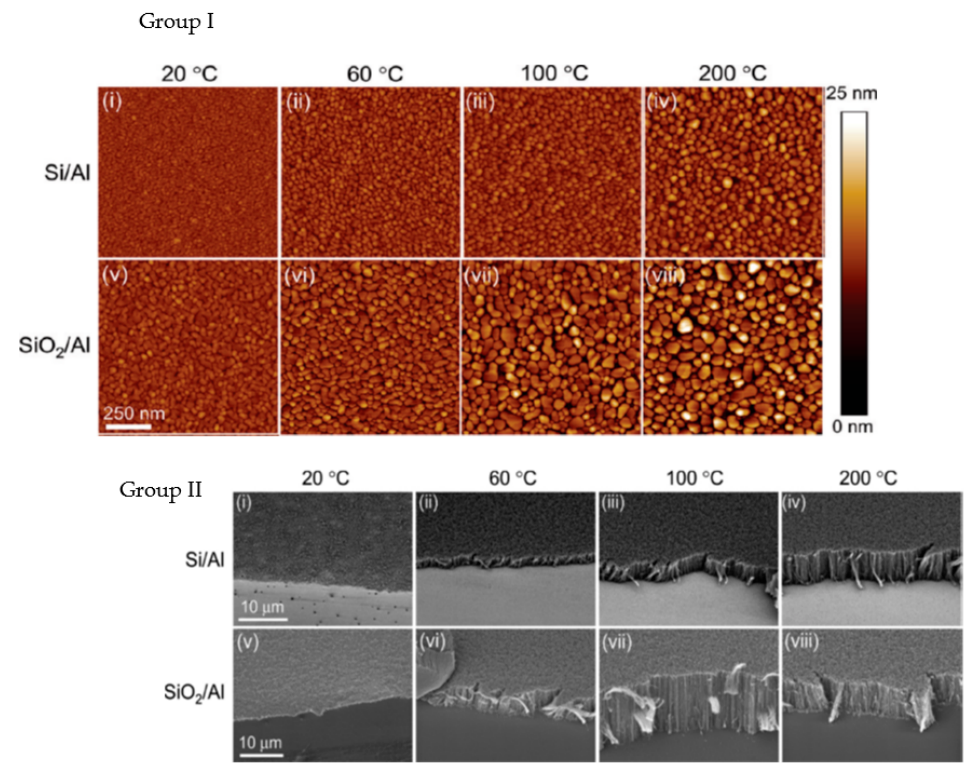
Figure 2. Group I ( i – viii )—AFM tapping mode height micrographs of Si, i.e., native SiO 2 , ( i – iv ) and SiO 2 ( v – viii ) with 10 nm Al DBL deposited at substrate temperatures of 20 ( i , v ), 60 ( ii , vi ), 100 ( iii , vii ), and 200 ◦ C ( iv , viii ), all other conditions kept identical. Group II ( i – viii )—SEM micrographs of single-wall VACNT growth on the substrates with DBL presented in Group I. Reprinted with permission from Burt, Journal of Physical Chemistry C; Ref. [65] copyright 2009, American Chemical Society.